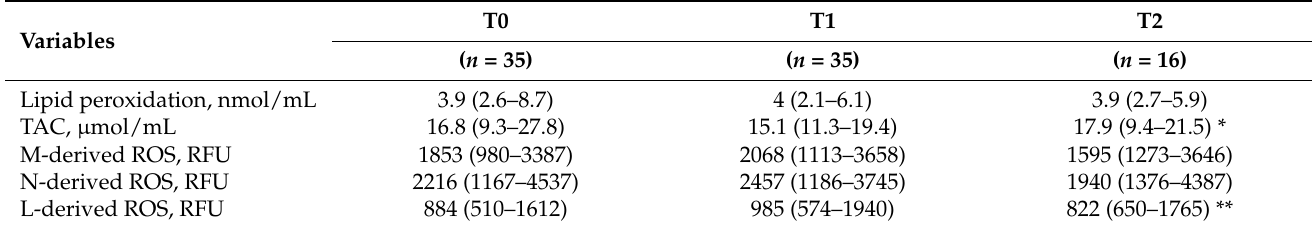
Table 8. Changes in Oxidative Stress Parameters.